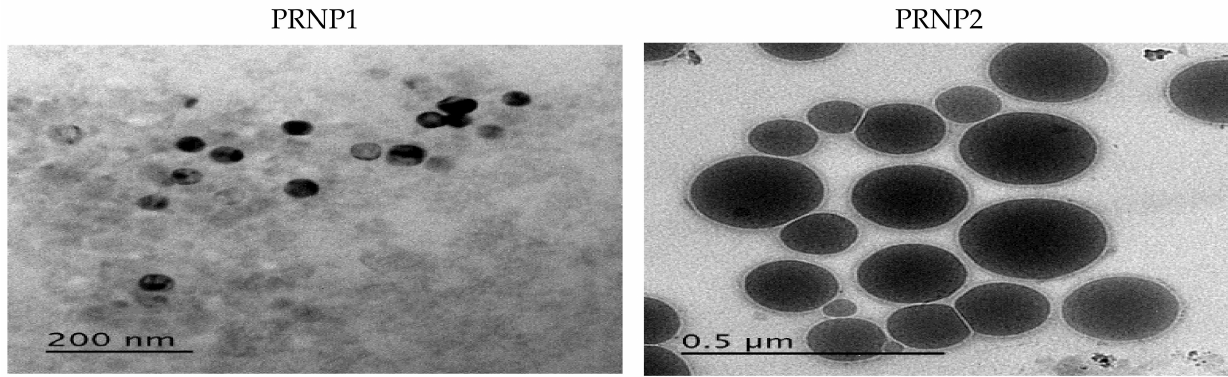
Figure 4. Transmission electron micrographs of prepared polymer nanoparticles of doxycycline pre- pared by nanoprecipitation technique, showing the particle size of prepared nanoparticles (displaced for better